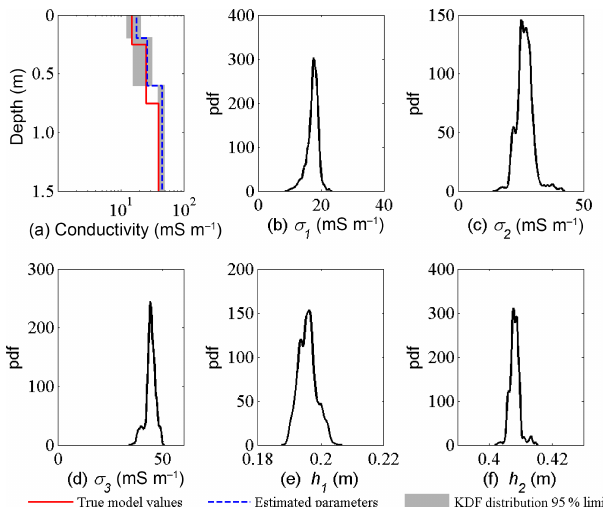
Figure 3. Summary of the MCMC simulation for the synthetic three-layer earth model of non-saline soil. (a) True (red line) and es- timated parameter (blue dashed line) for the vertical electrical con- ductivity profile, and the gray background with the 95% confidence interval of kernel distribution estimation (KDE). Panels (b–f) show the KDE of the marginalized posterior distributions for the three layer conductivities ( σ 1 , σ 2 , and σ 3 ) and the two layer thicknesses ( h 1 and h 2